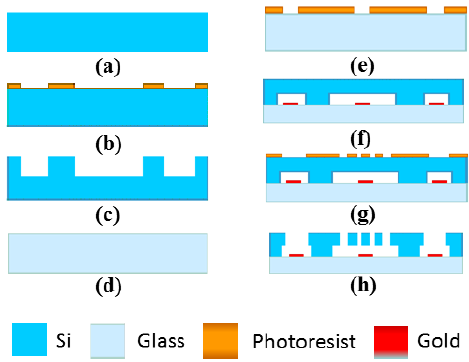
Figure 4. Fabrication process of MEMS tuning fork gyroscope.